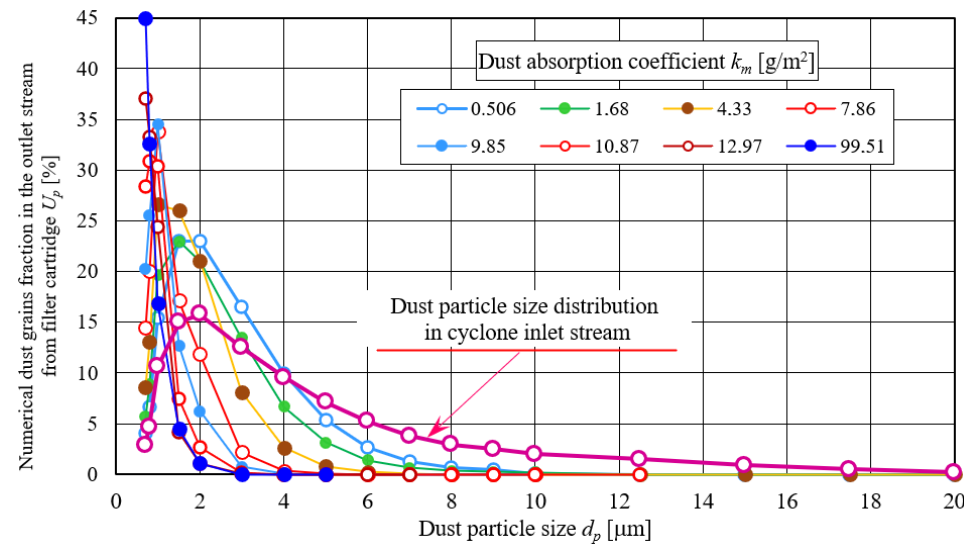
Figure 12. Dust grains particle size distribution in Q G stream downstream of the filter element in individual size ranges for different k m coefficient values.